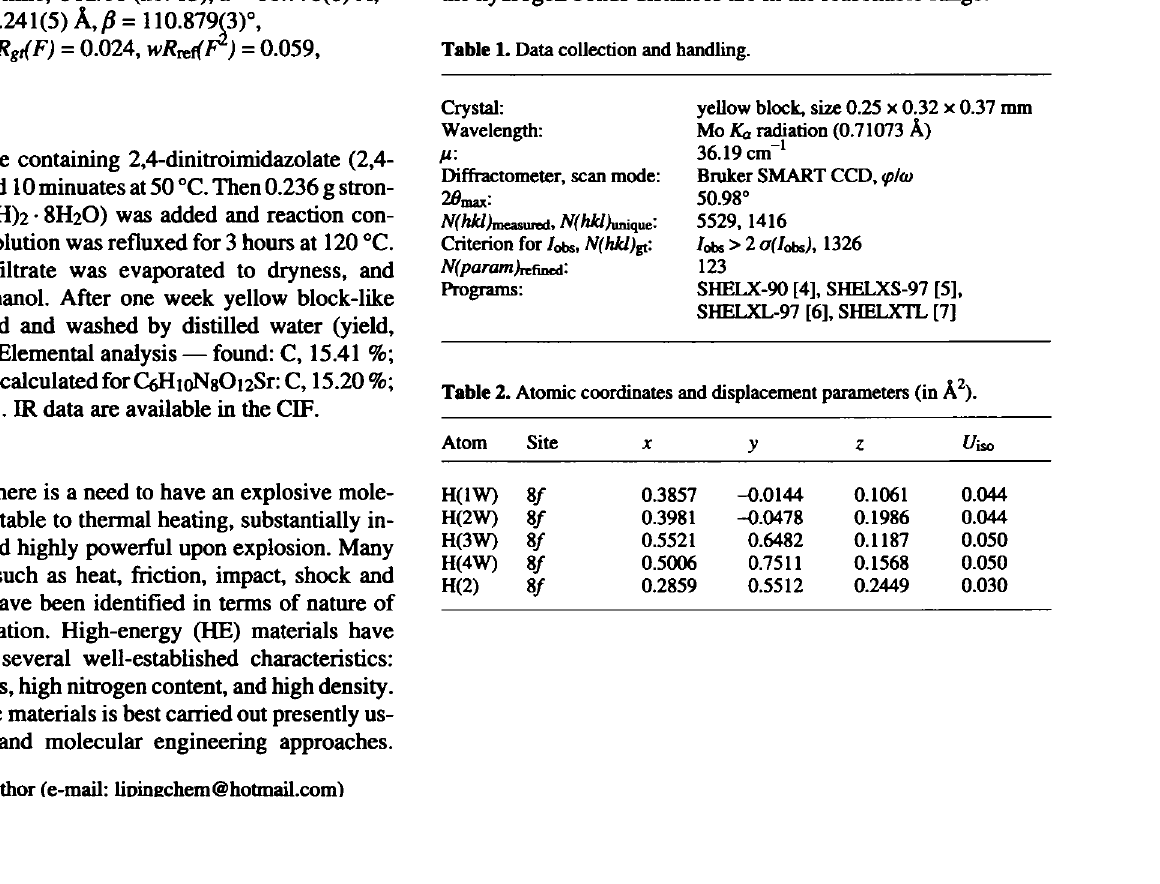
Table 1. Data collection and handling.